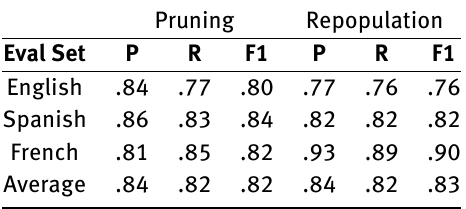
Table 1: Evaluation results of the pruning and repopulation phases of the algorithm using Dataset 1